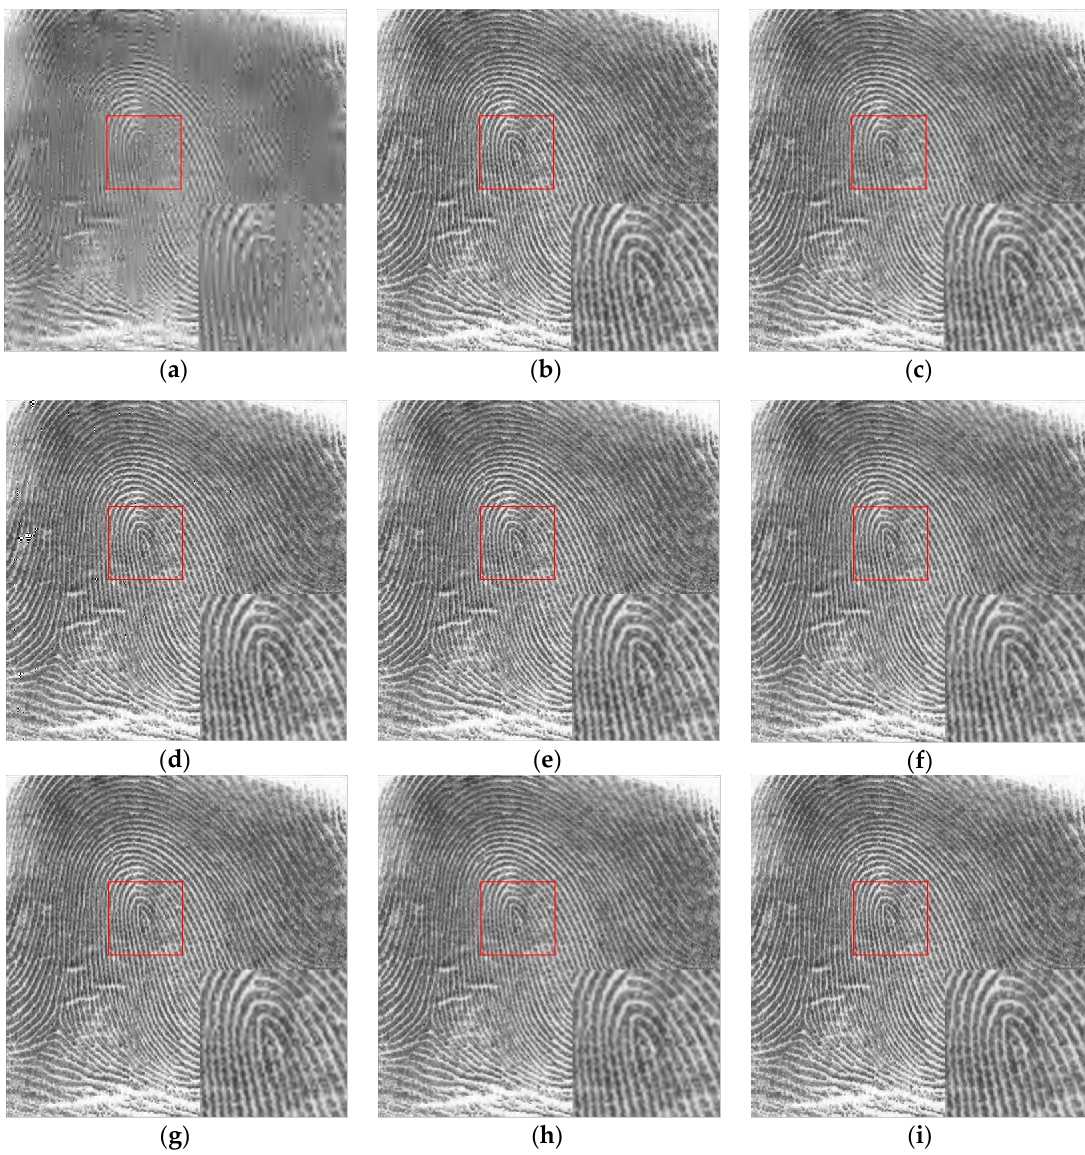
Figure 7. Reconstruction results of different algorithms of ( a ) SP, ( b ) IRLS, ( c ) OMP, ( d ) ROMP, ( e ) GOMP,